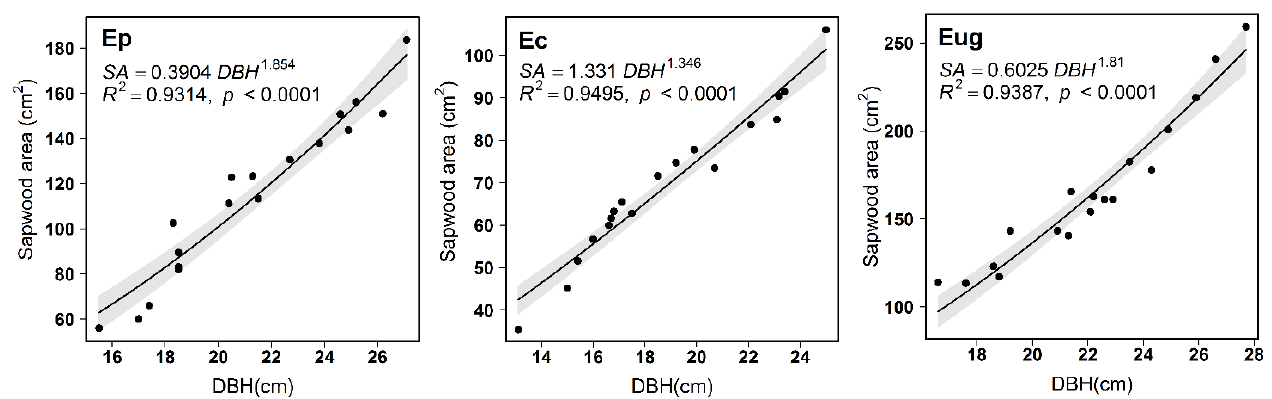
Figure 2. Variation in sapwood area as a function of individual trees’ DBH of three eucalyptus species. Ep, Ec, and Eug represent the eucalyptus species of E. pellita, E. camaldulensis and E. urophylla × E. grandis , respectively. The shaded bands denote the 95% confidence intervals.